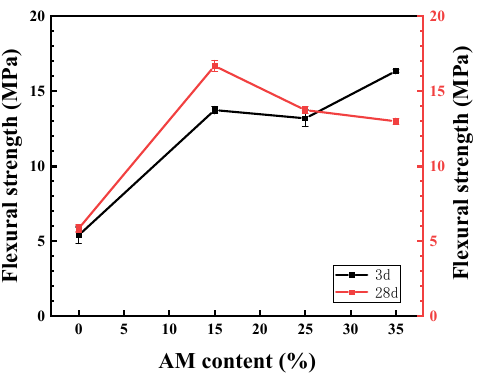
Figure 12. Effect of the AM content on the flexural strengths of cement stone samples at the ages of 3 d and 28 d.